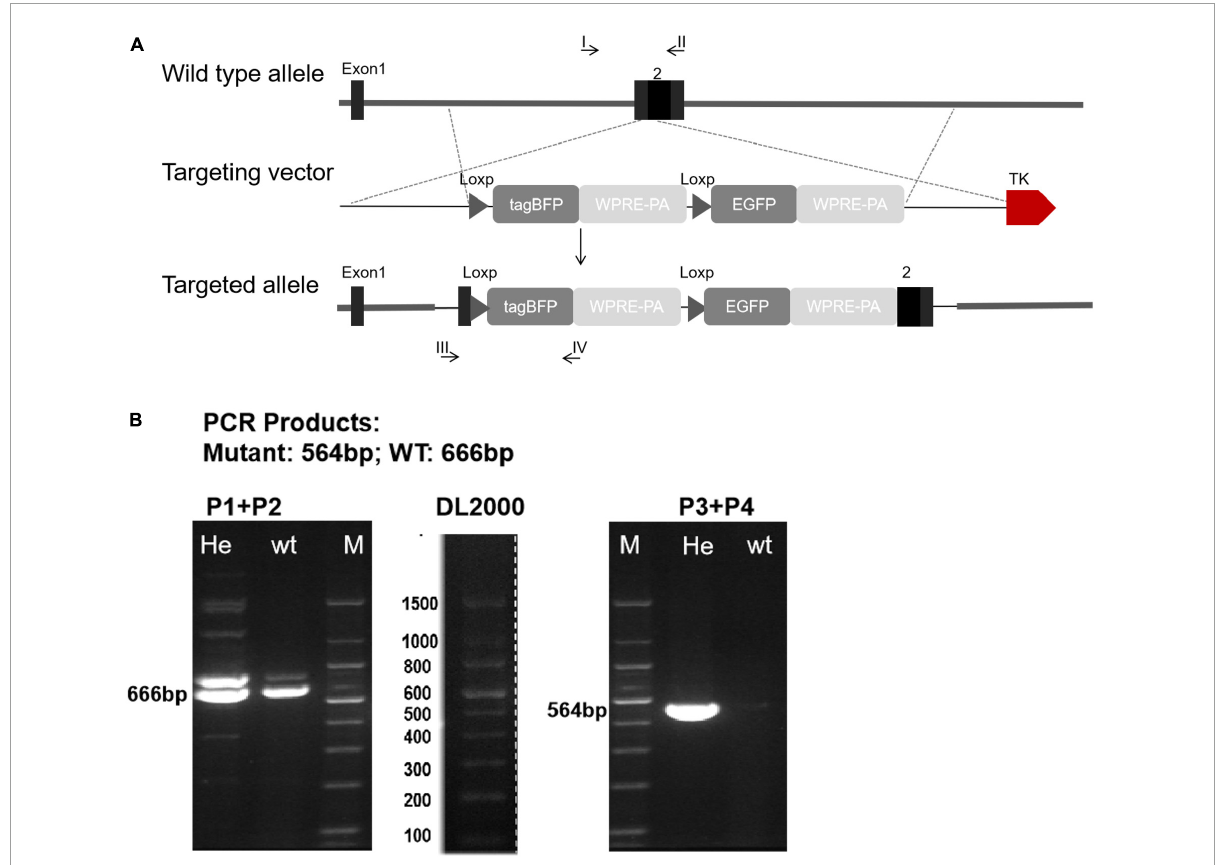
FIGURE2 Generation of Cx43-BFP-GFP/ + reporter line. (A) Schematic diagram showing the targeting strategy of Cx43-BFP-GFP allele by homologous recombination using CRISPR/Cas9; (B) polymerase chain reaction (PCR) of genomic DNA, P1 + P2 means primer1 + primer2; P3 + P4 means primer3 + primer4; Heterozygous amplified a 564 bp